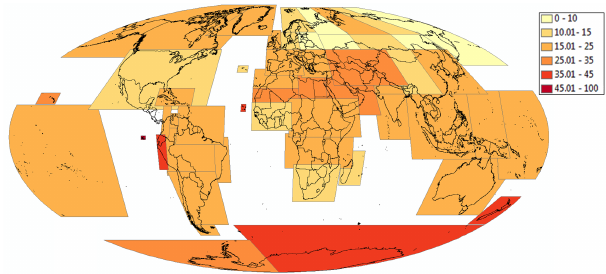
Figure 5. Percent standard error explained by